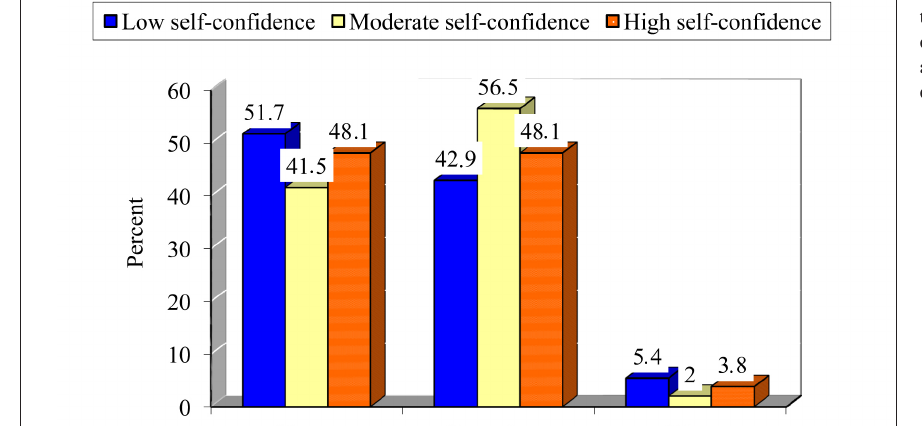
Figure 3. Percentage dis- tribution